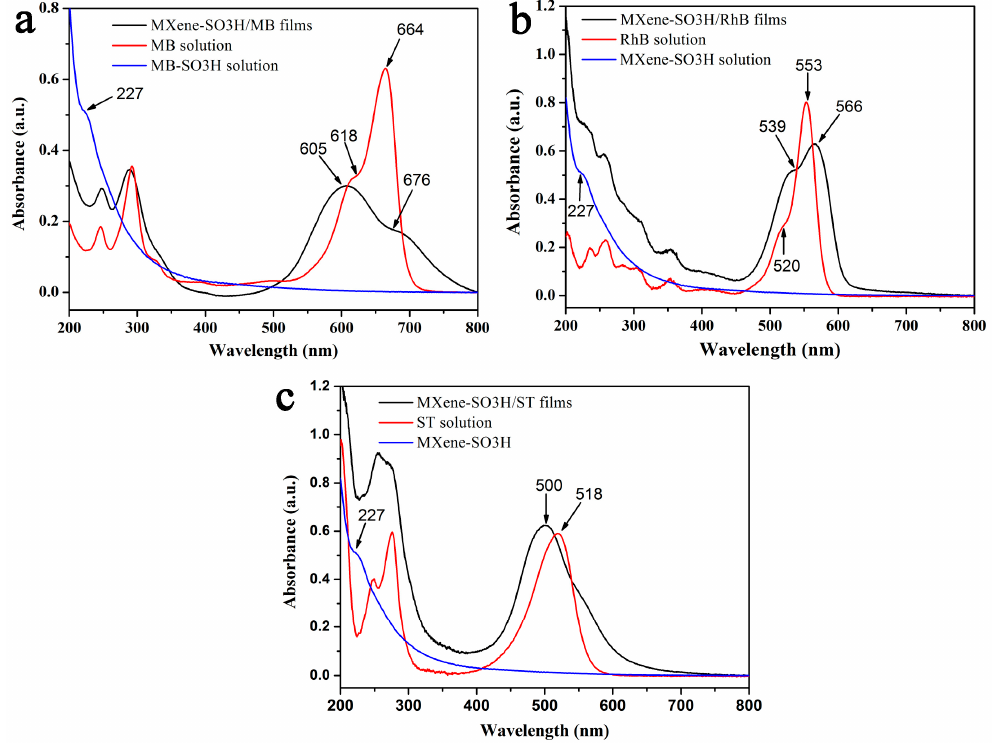
Figure 7. UV-Vis absorption spectra of the transferred multilayer MXene-SO3H/MB films ( a ), MXene-SO3H/RhB films ( b ), and MXene-SO3H/ST films ( c ).